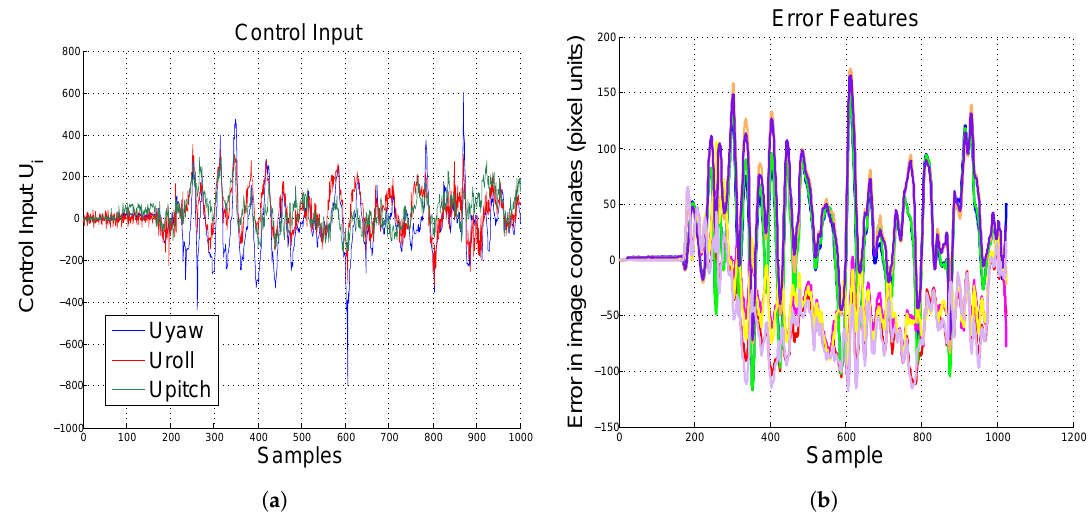
Figure 12. Experimental results at hover position when mass and moment of inertia changed. The pattern is moving during the test. ( a ) control input ANN-PID; ( b ) error